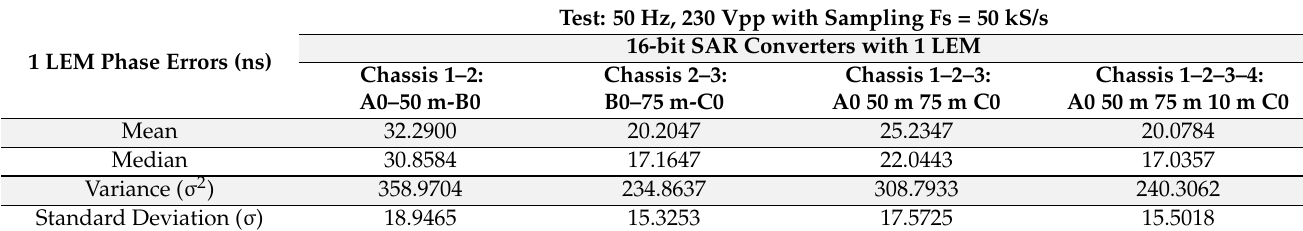
Table 8. Phase errors for SAR converters. Tests with one LV-25